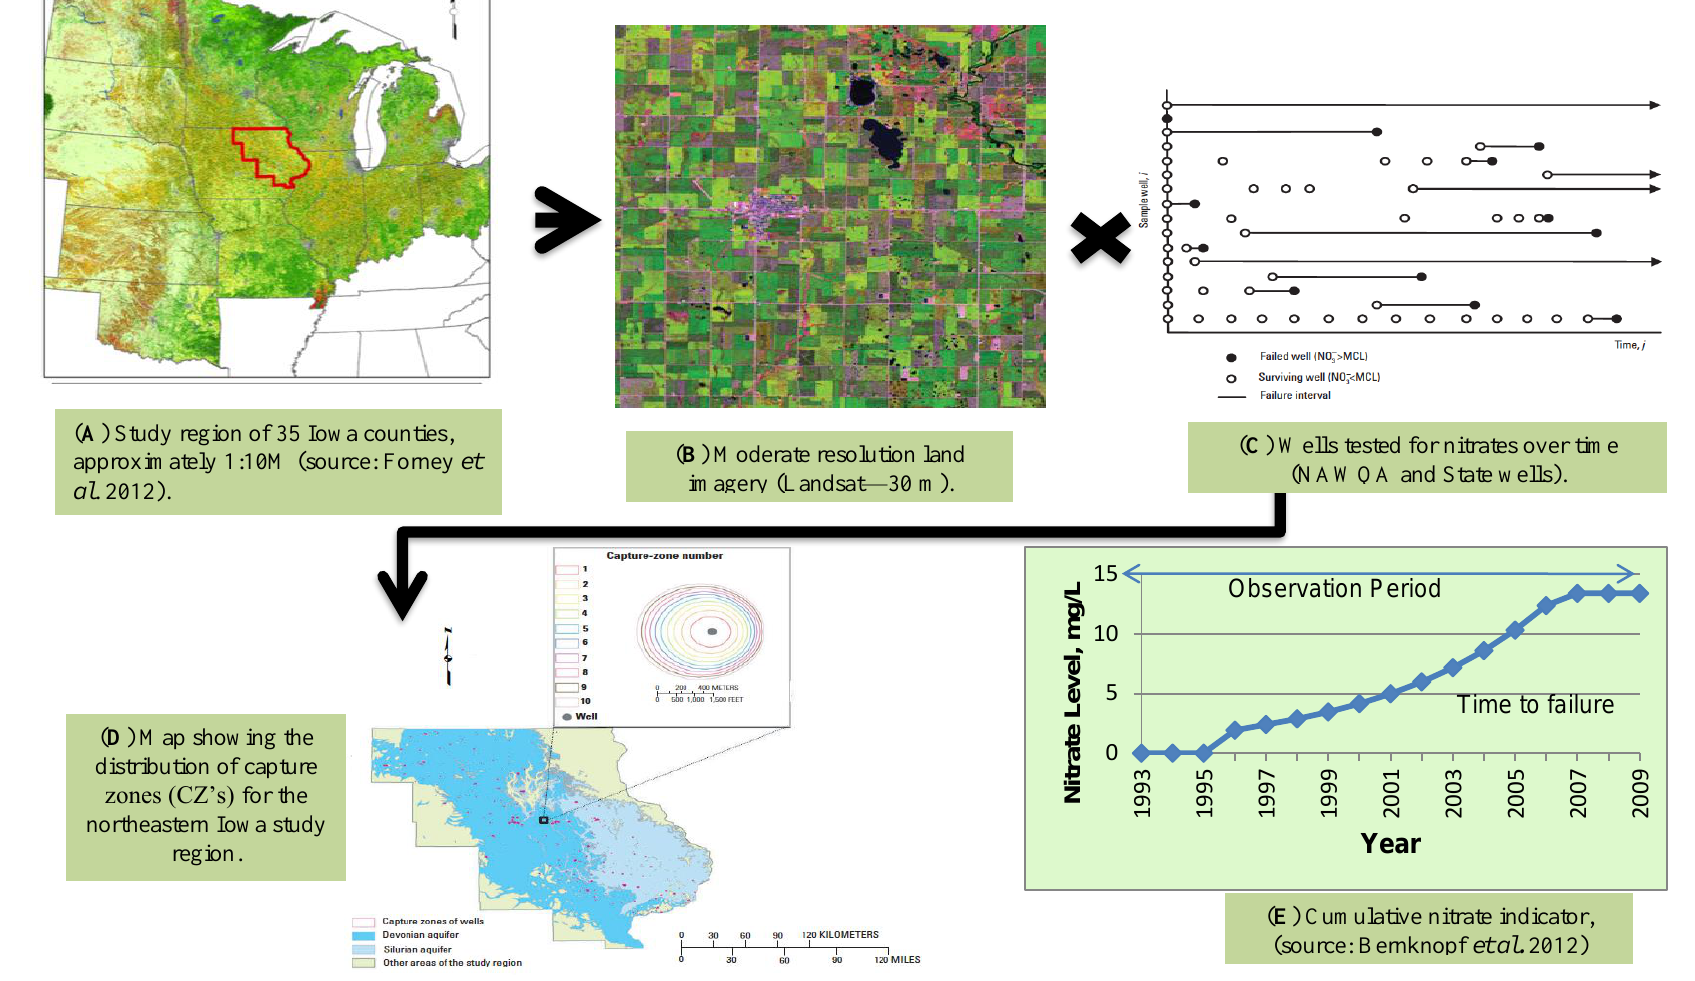
Figure 2. ( A ) Landsat image covering 35-county study region in Iowa, ( B ) Landsat image of parcels, ( C ) Illustration of arbitrarily interval-censored data used in the statistical survival model, ( D ) Regional map of wells and capture zones, and ( E ) Graph of nitrate accumulation over time for exceeding the regulatory standard (source: